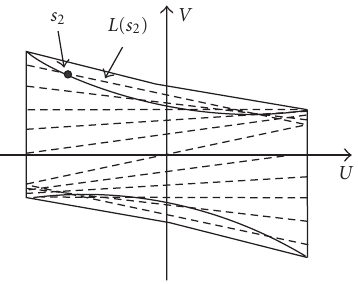
Figure 3: Tam-Danielsson window. The Tam-Danielsson window is a region on the detector plane. It is bounded by the cone-beam projection of the upper and lower turns of the spiral onto the detec- tor plane.